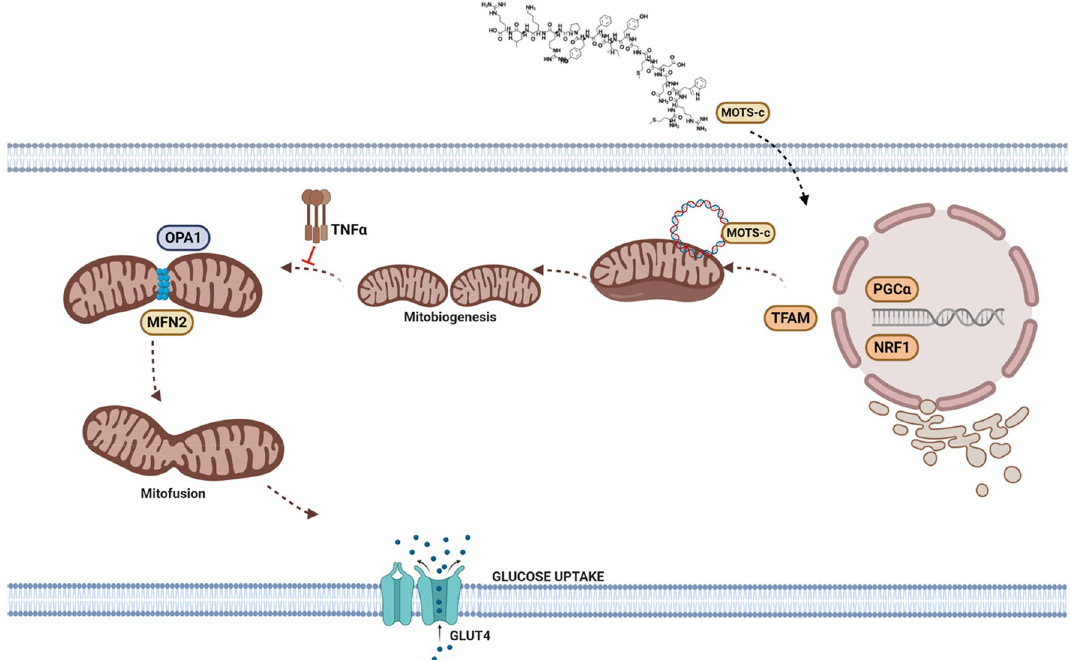
Figure 8. A schematic representation of mitochondrial changes and pathways underlying the ability of mitochondrial peptide MOTS ‐ c to prompt GLUT4